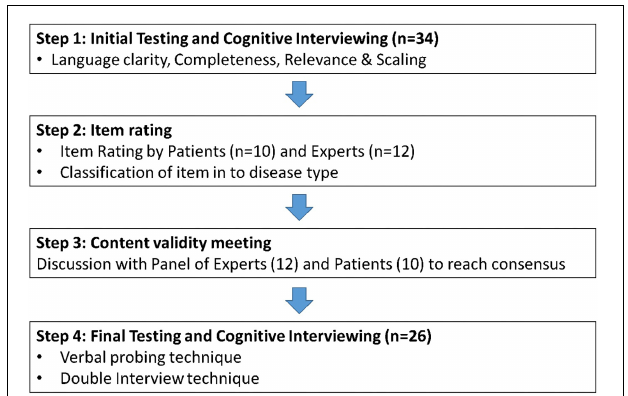
FIGURE 1 | Four-step approach for Content and Face validation of the